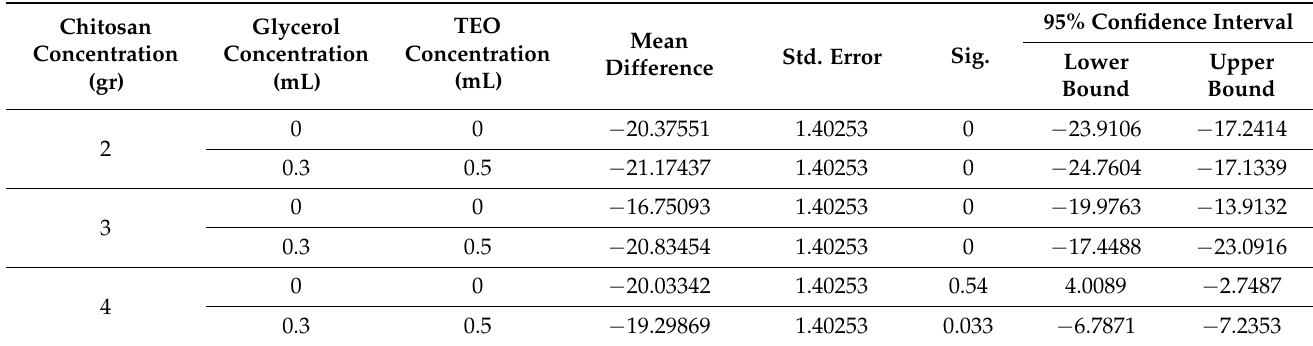
Table 2. Tensile strength for all samples using ANOVA method for difference samples. Chitosan